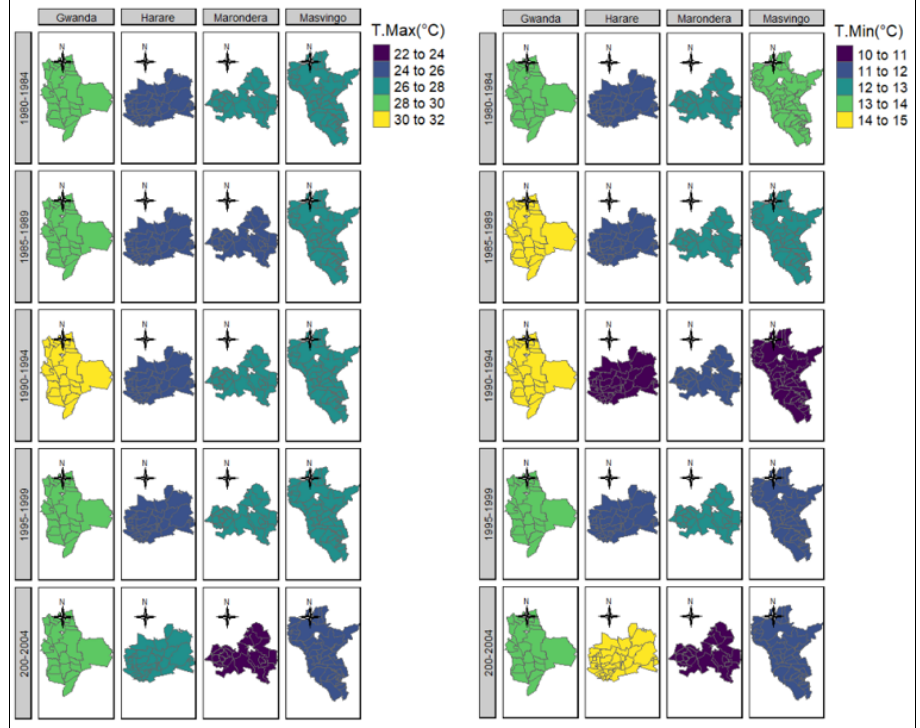
Figure 9. Temperature changes at 5-year intervals in the districts where meteorological stations are located in Zimbabwe.